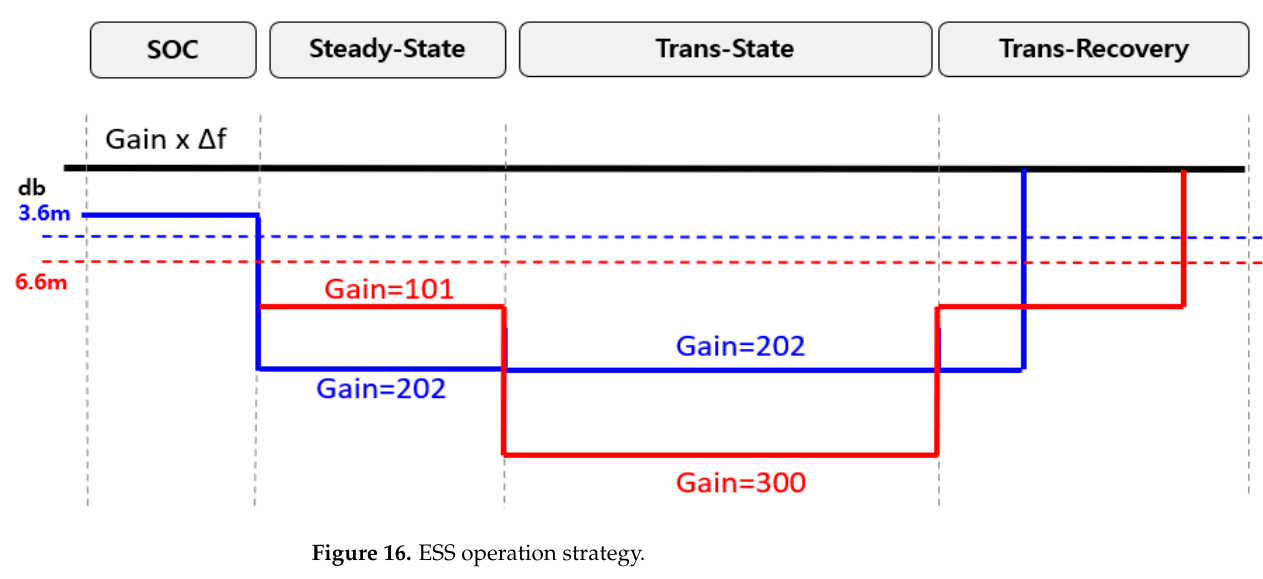
Figure 16. ESS operation strategy. Table 15. Lowest frequency applying optimal parameters (generator trip) (Hz):